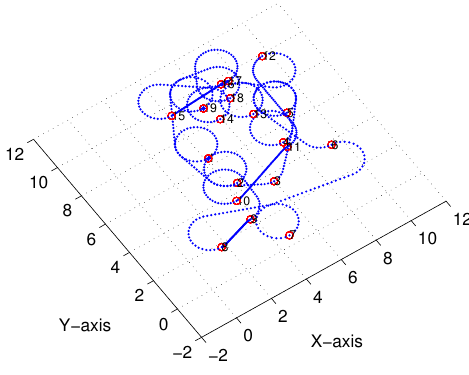
Figure 21. X – Y projection of Bezier interpolation three-dimensional (3D) Dubins curves (case 2).